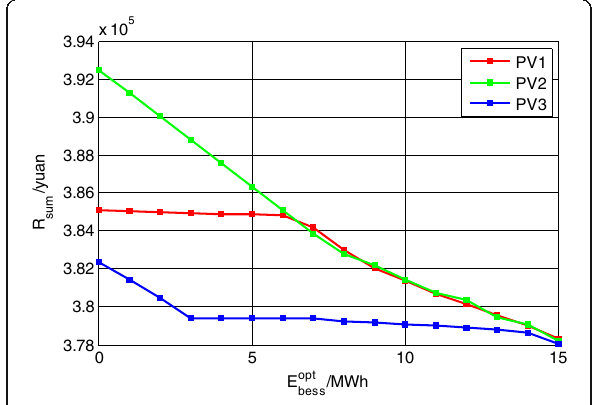
− R sum under different actual PV bess